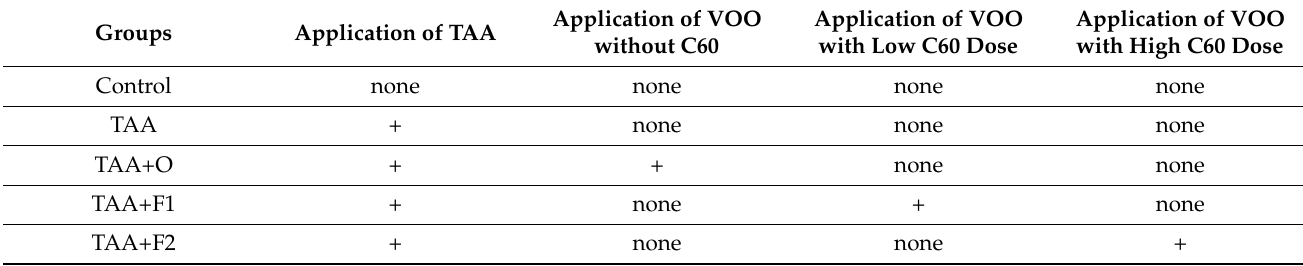
Table 1. The study designs. Control—control group of animals (free access to tap water and commercial standard rat food); TAA—thioacetamide group of animals (free access to commercial standard rat food, and tap water with the thioacetamide dissolved in 300 mg/L concentration); TAA+O—thioacetamide + virgin olive oil group of animals (free access to commercial standard rat food enriched with the oil in 10% mass/mass concentration, and tap water with the thioacetamide dissolved in 300 mg/L concentration); TAA+F1—thioacetamide + fullerene C60 low dose group of animals (free access to commercial standard rat food enriched with the oil in 10% mass/mass concentration in which C60 was dissolved in 0.2 mg/mL concentration, and tap water with the thioacetamide dissolved in 300 mg/L concentration); and TAA+F2—thioacetamide + fullerene C60 high dose group of animals (free access to commercial standard rat food enriched with the oil in 10% mass/mass concentration in which C60 was dissolved in 1 mg/mL concentration, and tap water with the thioacetamide dissolved in 300 mg/L concentration). The experiment lasted 4 months. The number of animals per group = 8. Application of VOO Application of VOO Application of VOO Groups Application of TAA without C60 with Low C60 Dose with High C60